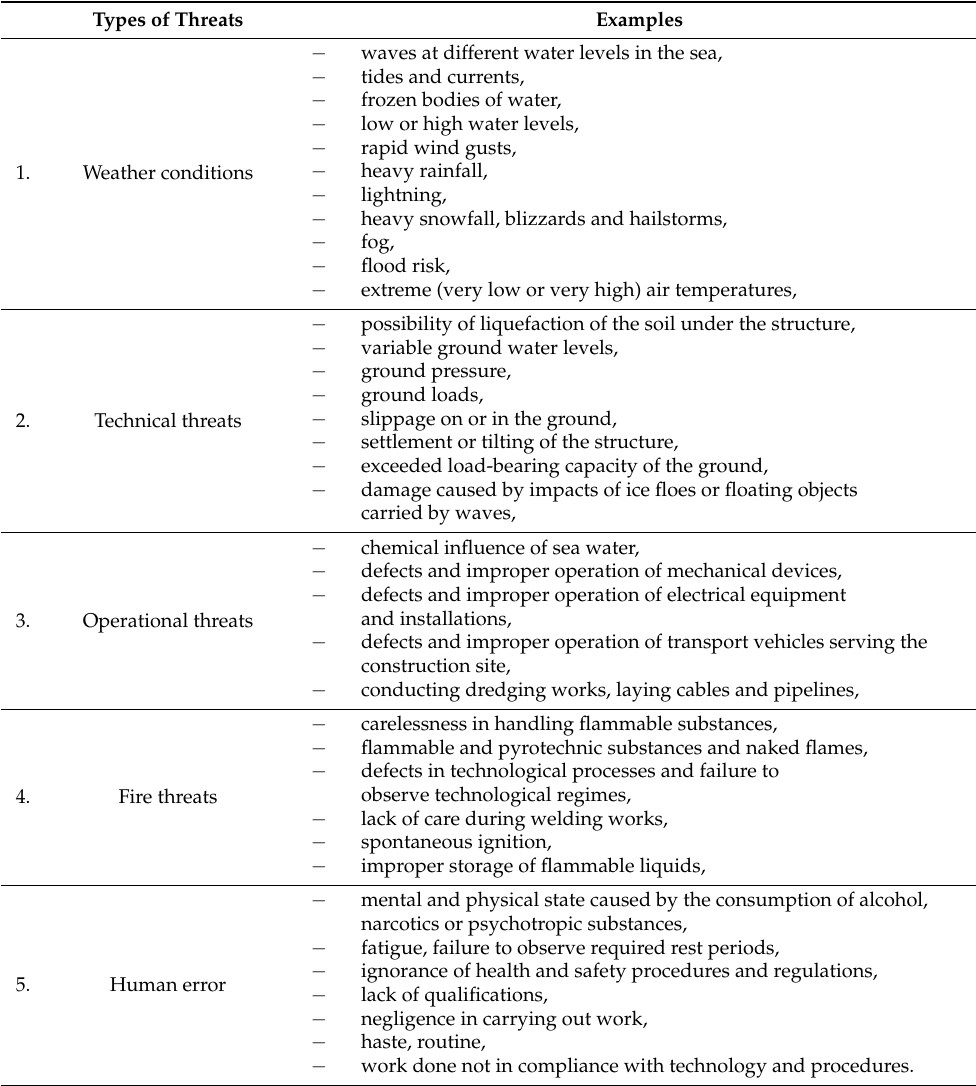
Table 2. Threats in planned water area of the